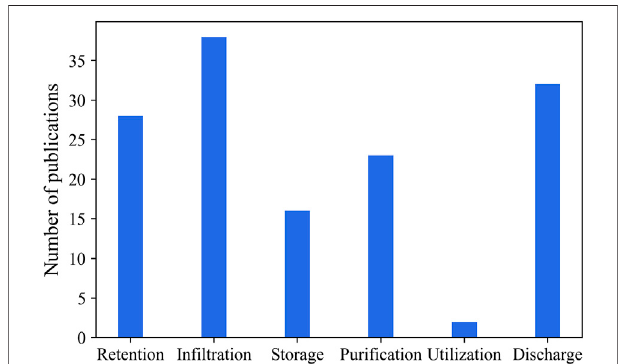
FIGURE 3 | Breakdown of the six hydrological processes included in Sponge City case studies in China.